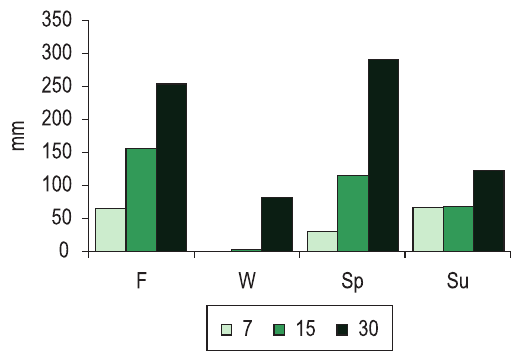
Figure 1. Precipitation accumulated values in the last 7,15 and 30 days before each sampling in the four seasons. F = Fall, W = Winter, Sp = Spring and, Su =